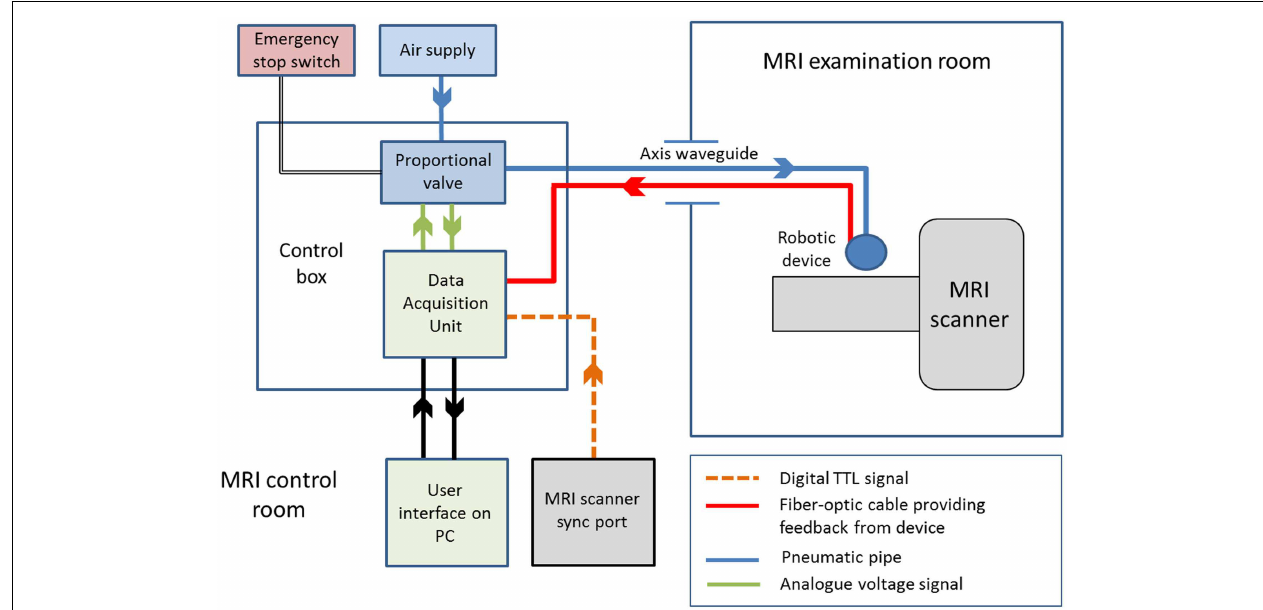
through the pneumatic connection (running through the axis waveguide) to the device in the MRI examination room. Complete control of the system is achieved via a user interface running on PC software, and integration of the multimodal information through a data acquisition